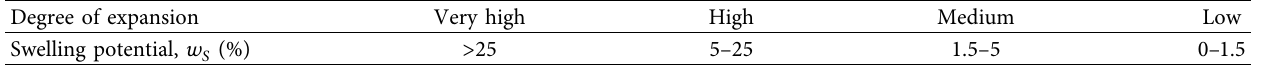
2 . 44 ) [21]. � 0.00216 ∗ I S (%) P